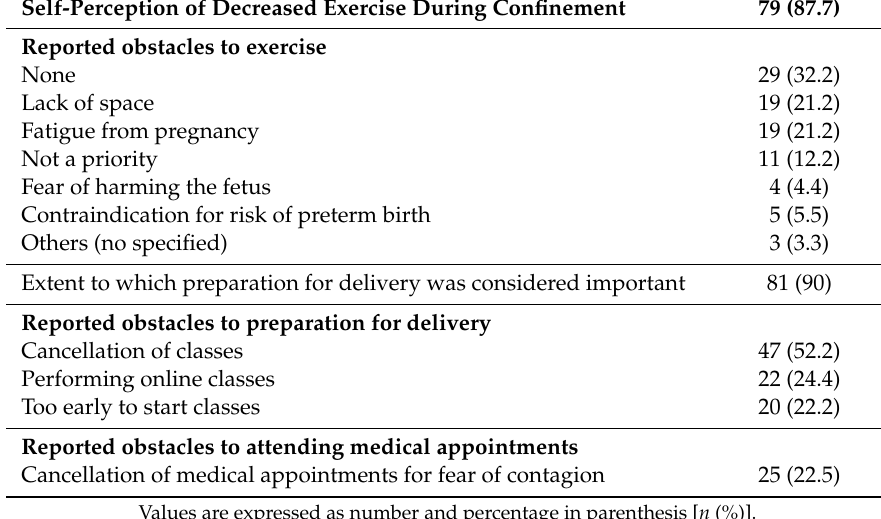
Table 2. Self-perception and perceived obstacles to exercise, preparation for delivery, and medical monitoring of their pregnancy during the confinement.